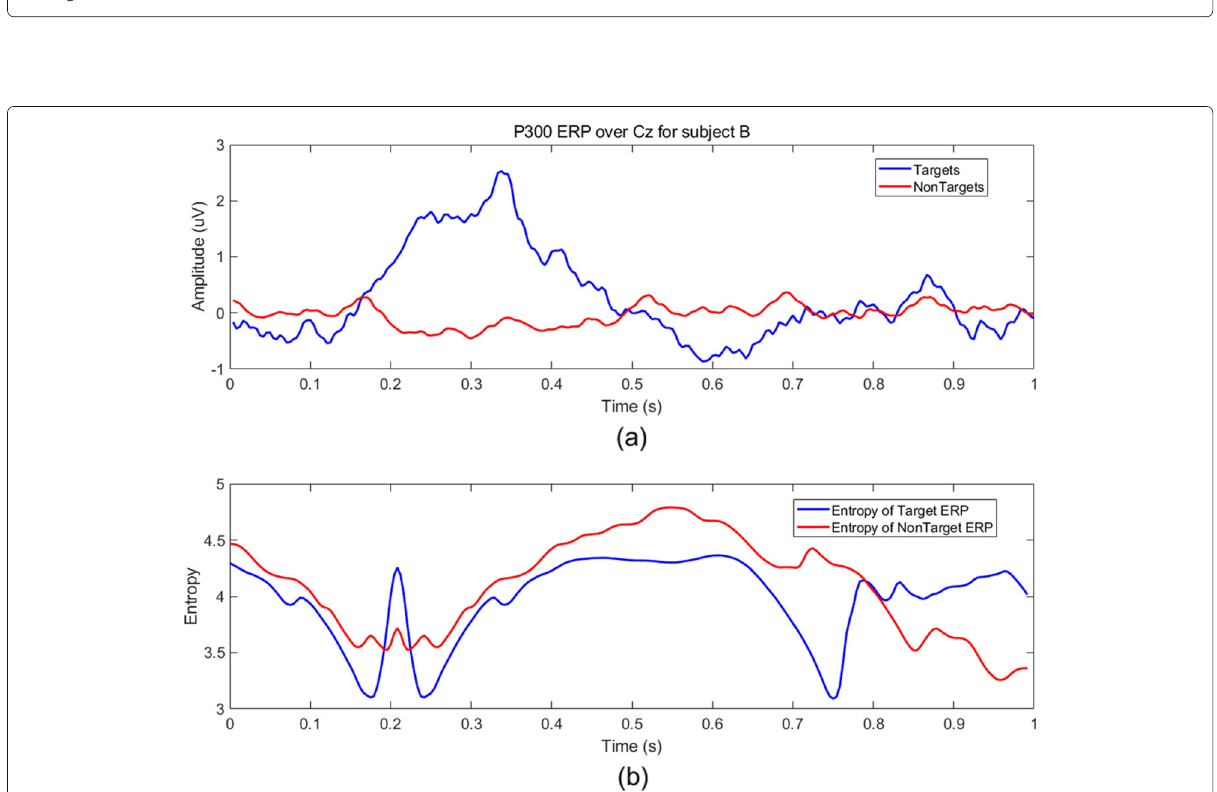
Fig. 14 Visual P300 experiment recorded at electrode Cz for subject B. a Trial average ERPs of targets and non-targets. b Short-term Rényi entropy of averaged